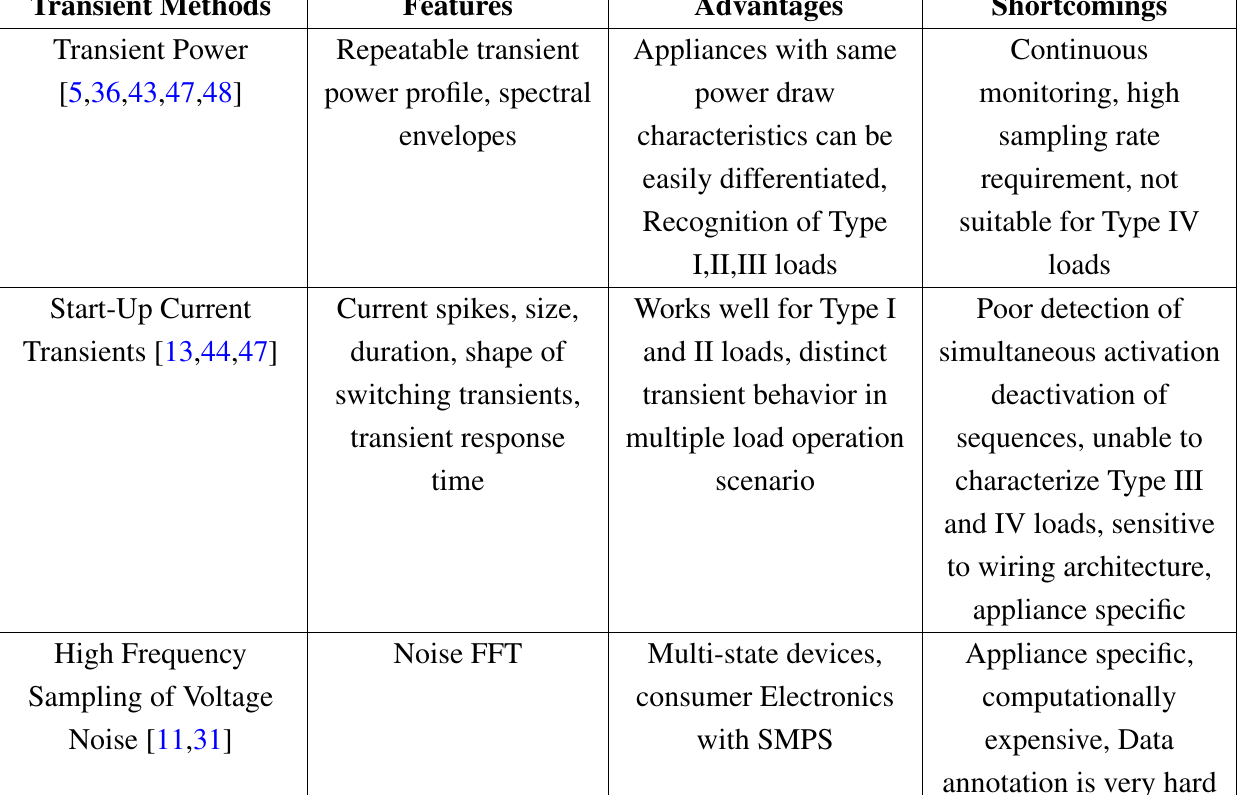
Table 2. Summary of transient-state